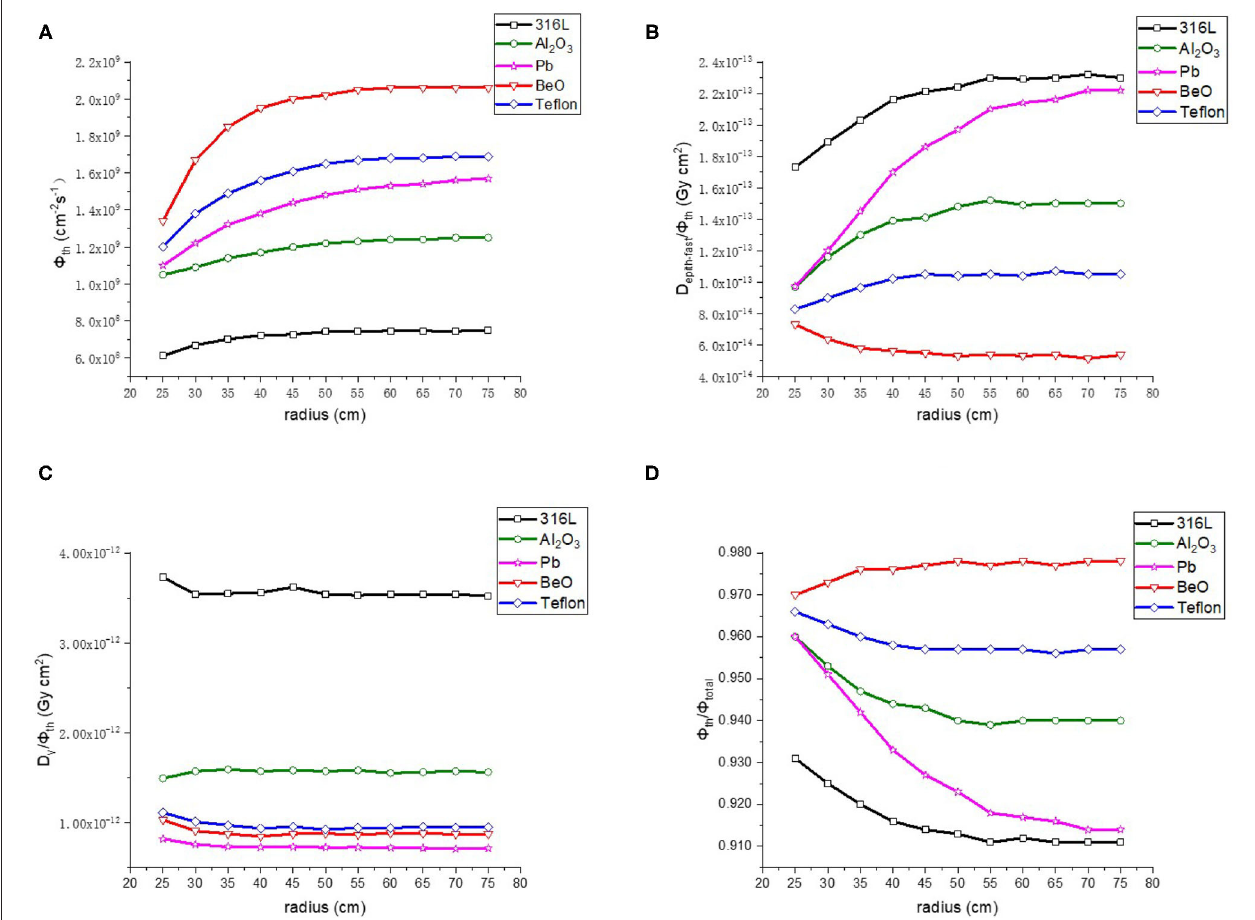
FIGURE 5 | Thermal neutron parameters of reflector, (A–D) are thermal neutron flux, thermal neutron ratio, epithermal, and fast neutron component, Gamma component, respectively.